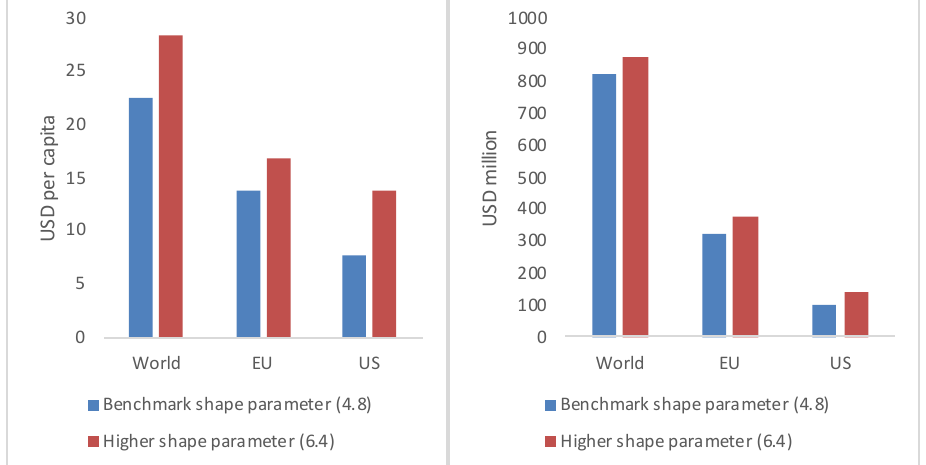
Source: Simulation